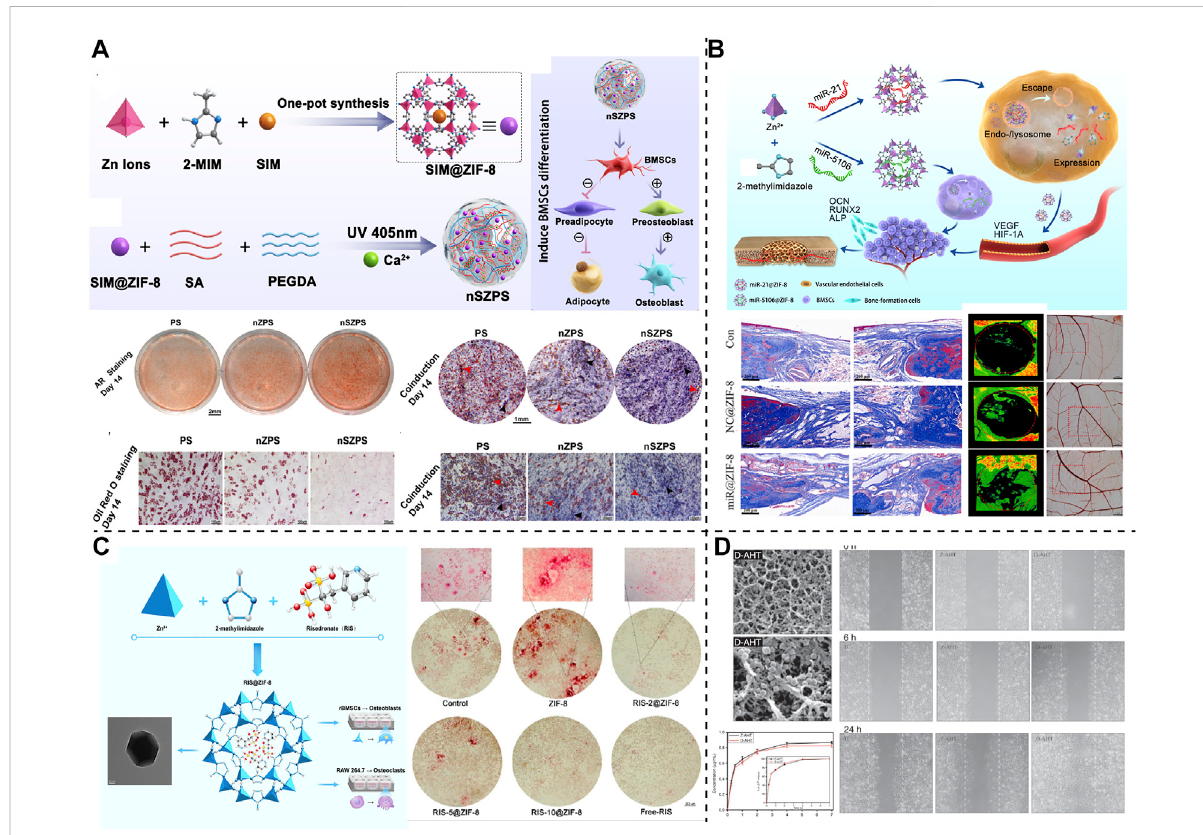
FIGURE 4 ZIF-8-based MNPs were demonstrated for building bone tissue engineering materials. (A) SIM@ZIF-8 carried hydrogel designed for regulating the balance of osteogenic and adipogenic differentiation, copyright 2022 Elsevier. (B) A ZIF-8 loading miRNA promoting vascularized bone formation, copyright 2021 Elsevier. (C) A ZIF-8-based MNP aiming at preventing osteoclasts, copyright 2019 ACS Publications. (D) Bone implants modi fi ed with DMOG@ZIF-8, copyright 2019 SAGE